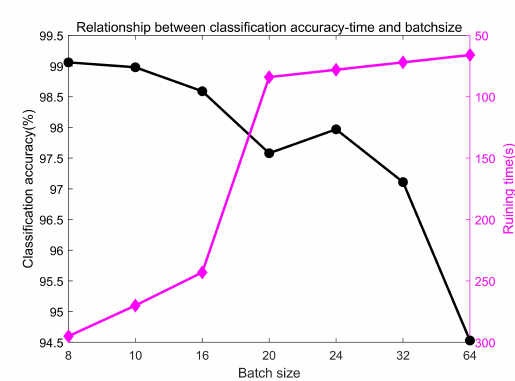
Figure 8. Relationship between classification accuracy-time and batch size.